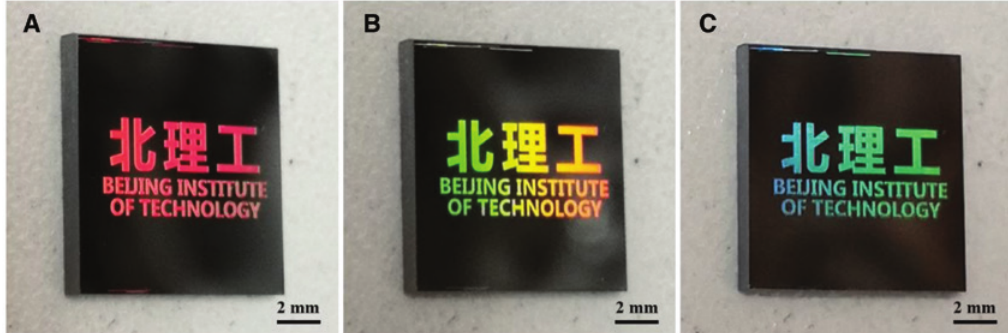
Figure 7: A Si surface with complex patterned graphics made up of 2D nanograting structures with cross scales from 790 nm to 0.75 cm. (A–C) The structural colors of the Si surface are observed from different angles captured by an ordinary camera under indoor